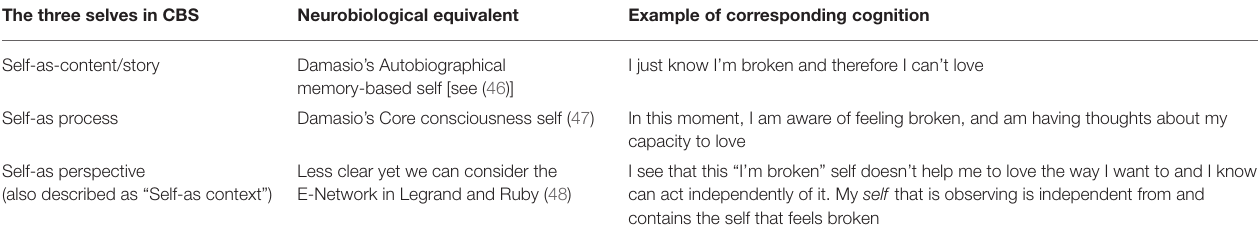
TABLE 1 | Example of content moving therapeutically through the three selves of